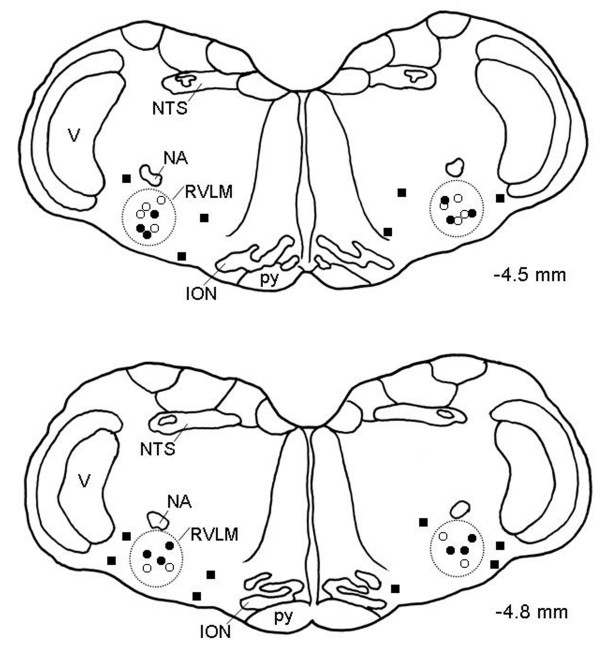
Microinjection sites of E2β and DPN in the RVLM. Diagrammatic representations of two rostral-caudal levels of the RVLM (dotted line areas) with reference to the lambda illustrating the location of sites where bilateral microinjection of E2β (black circle, 5 pmol) and DPN (◦,5 pmol) elicited significant inhibitory or minimal effects (black square, non-RVLM microinjection sites) on the MSAP and power density of vasomotor components of SAP spectrum. Numbers on right side indicate distance from the lambda. For the purpose of clarity, approximately 20% of the total microinjection sites are included and are presented on both side of the diagram. ION, inferior olivary nucleus; NA, nucleus ambiguous; NTS, nucleus tractus solitarii; RVLM, rostral ventrolateral medulla; V, nucleus of the spinal trigeminal nerve; py, pyramidal tract.